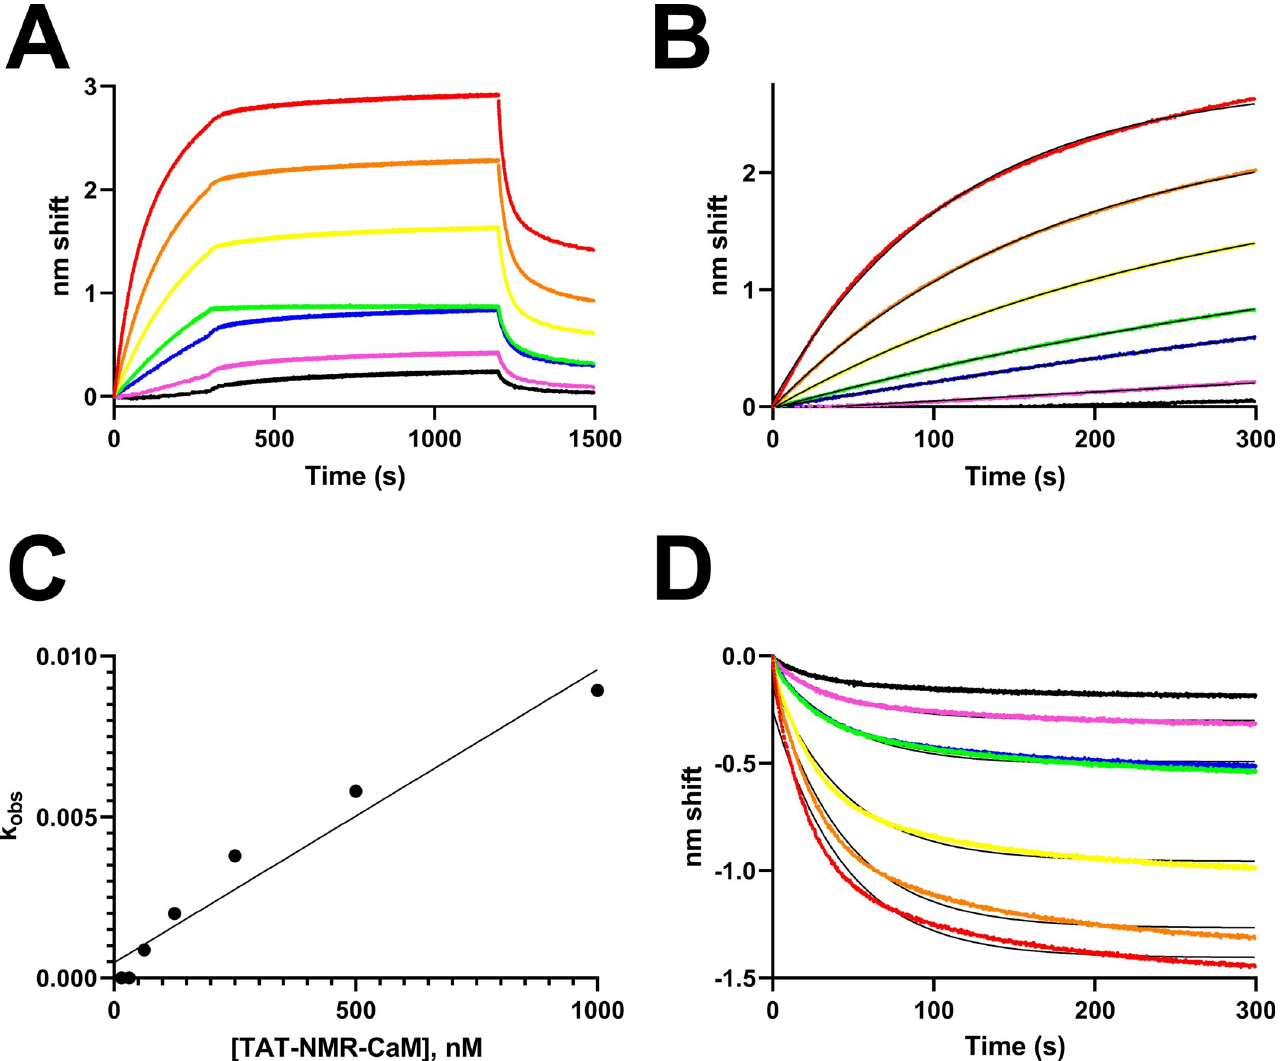
Fig 2. BLI analysis of TAT-NMR-CaM/CBS-MBP binding. A, sensorgram of association (0-300s), dissociation (300-1200s) and dissociation in 10 mM EDTA (1200-1500s) of sensor-tethered CBS-MBP binding to analyte TAT-NMR-CaM in which the association phase concentration was 1000 nM (red), 500 nM (orange), 250 nM (yellow), 125 nM (green), 63 nM (blue), 31 nM (magenta) and 16 nM (black). Data shown are reference subtracted against a sensor loaded with CBS-MBP run in parallel against buffer-only wells, including EDTA. B, Association phase from A fit to a single-state binding model. Raw data are colored points and fits are shown as black lines. C, k obs extracted from fits to B plotted against analyte concentration from which k a and k d were determined by slope and y- intercept, respectively. D, EDTA dissociation normalized to the start of the phase fit to a global single-state model.